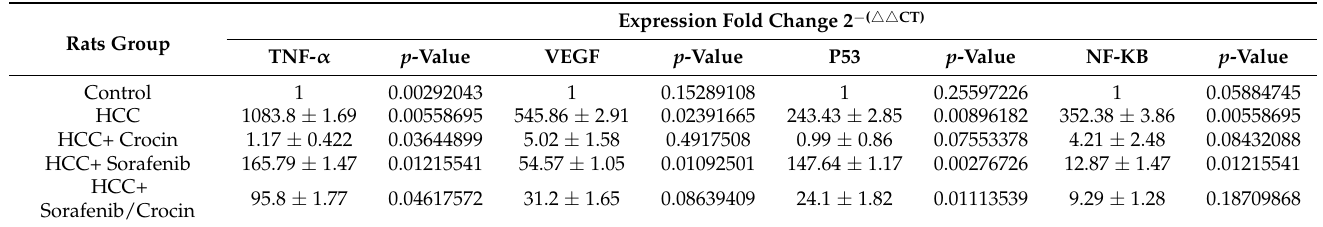
Table 4. Expression fold changes of TNF-a, VEGF, P53 and NF-KB in HCC induced rats and in HCC rats treated with crocin, sorafenib or a combination of both drugs.